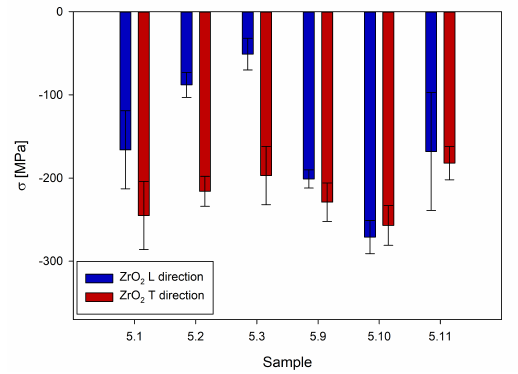
Figure 4. Values of macroscopic residual stresses after grinding by diamond disc (samples x.1-x.3) and AAT (samples x.9-x.11) of ZrO